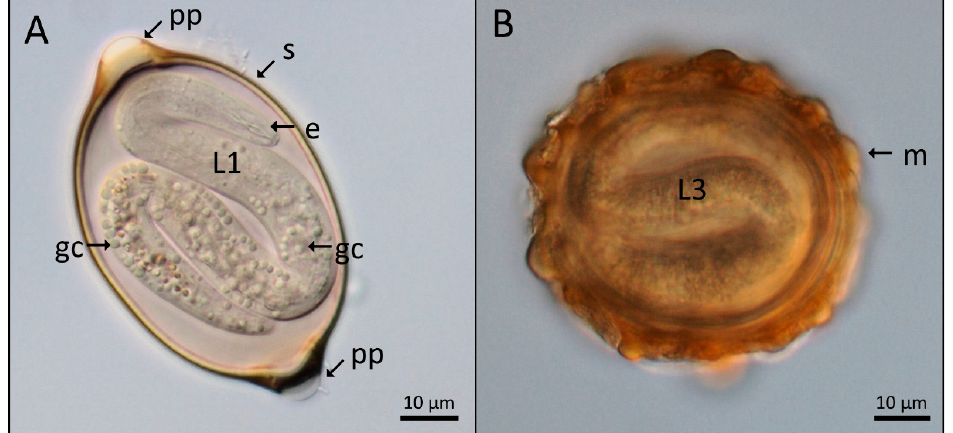
Figure 1. Light microscopy (DIC) of nematode eggs. ( A ): Trichuris muris egg showing in the eggshell (s) extremities two polar plugs (pp). Inside the egg are the first-stage larvae (L1), with the esophagus (e) and germinative cells (gc). ( B ): Ascaris lumbricoides egg showing the external mamillated layer (m) and the third-stage larvae (L3).